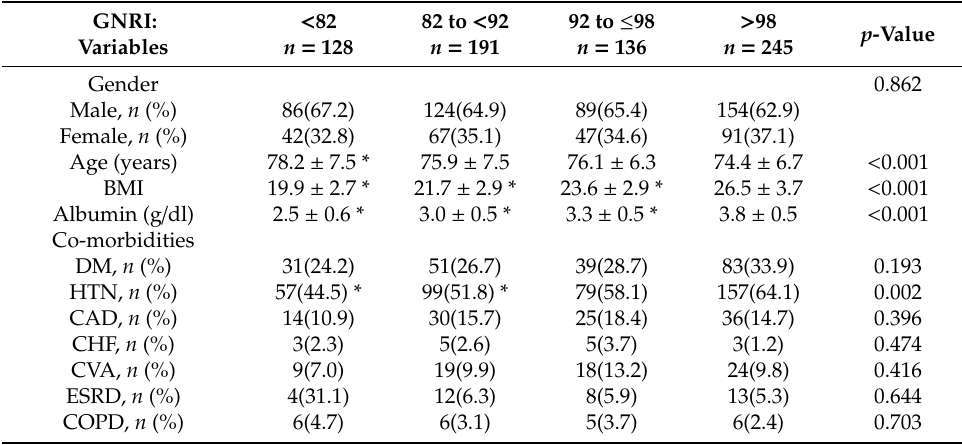
Table 3. Patient characteristics and outcomes of the ICU elderly trauma patients with di ff erent risks of malnutrition according to